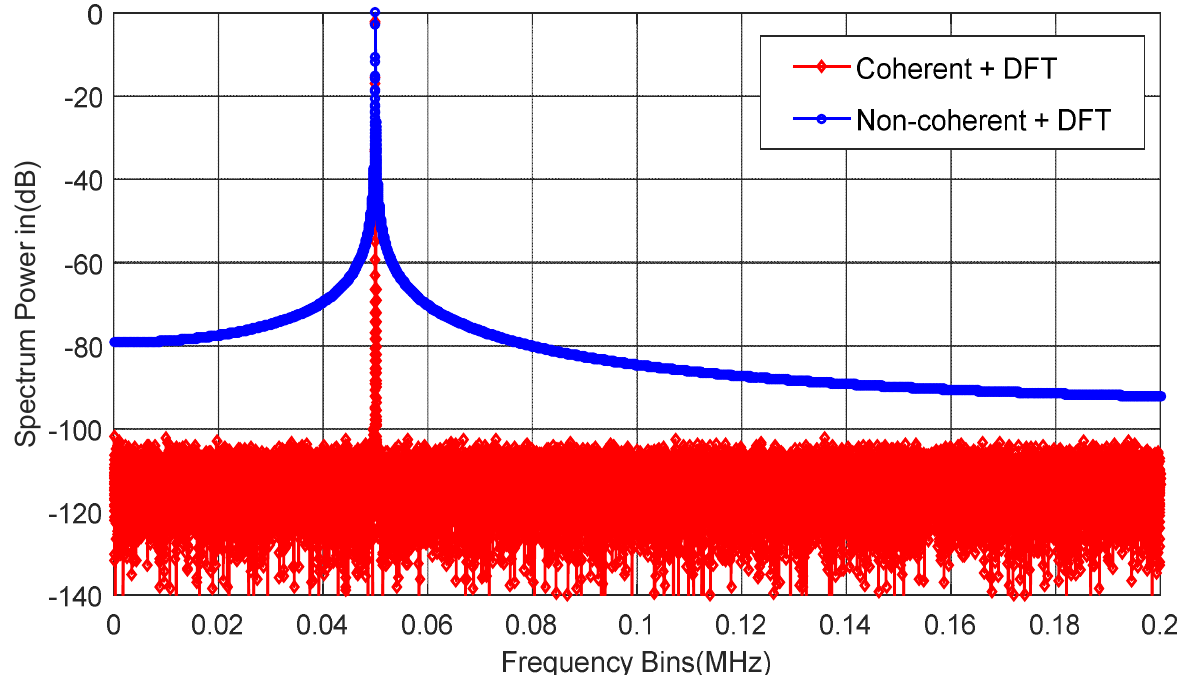
Figure 1. Coherent (red) and non-coherent (blue) sampling spectra.